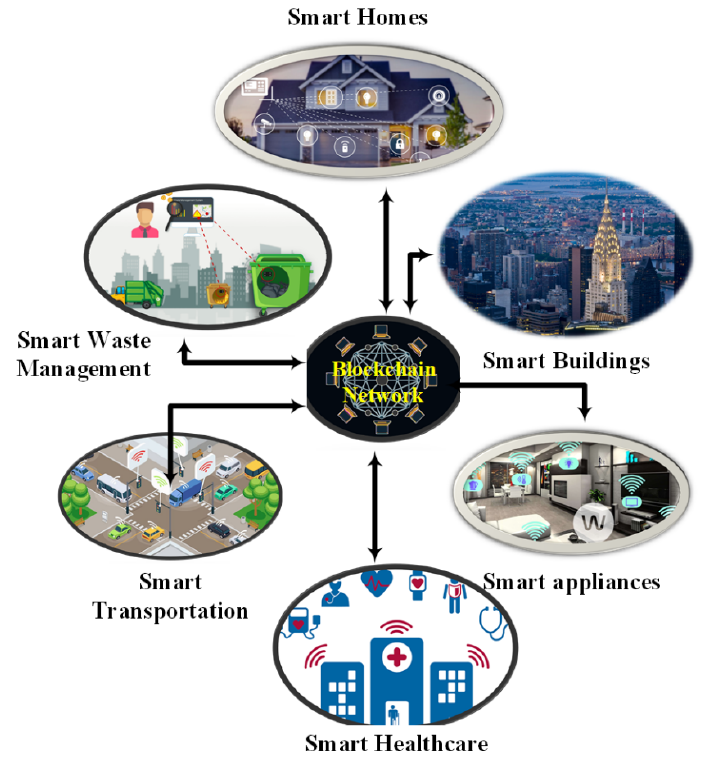
Figure 8. Overview of a blockchain architecture for SCs.